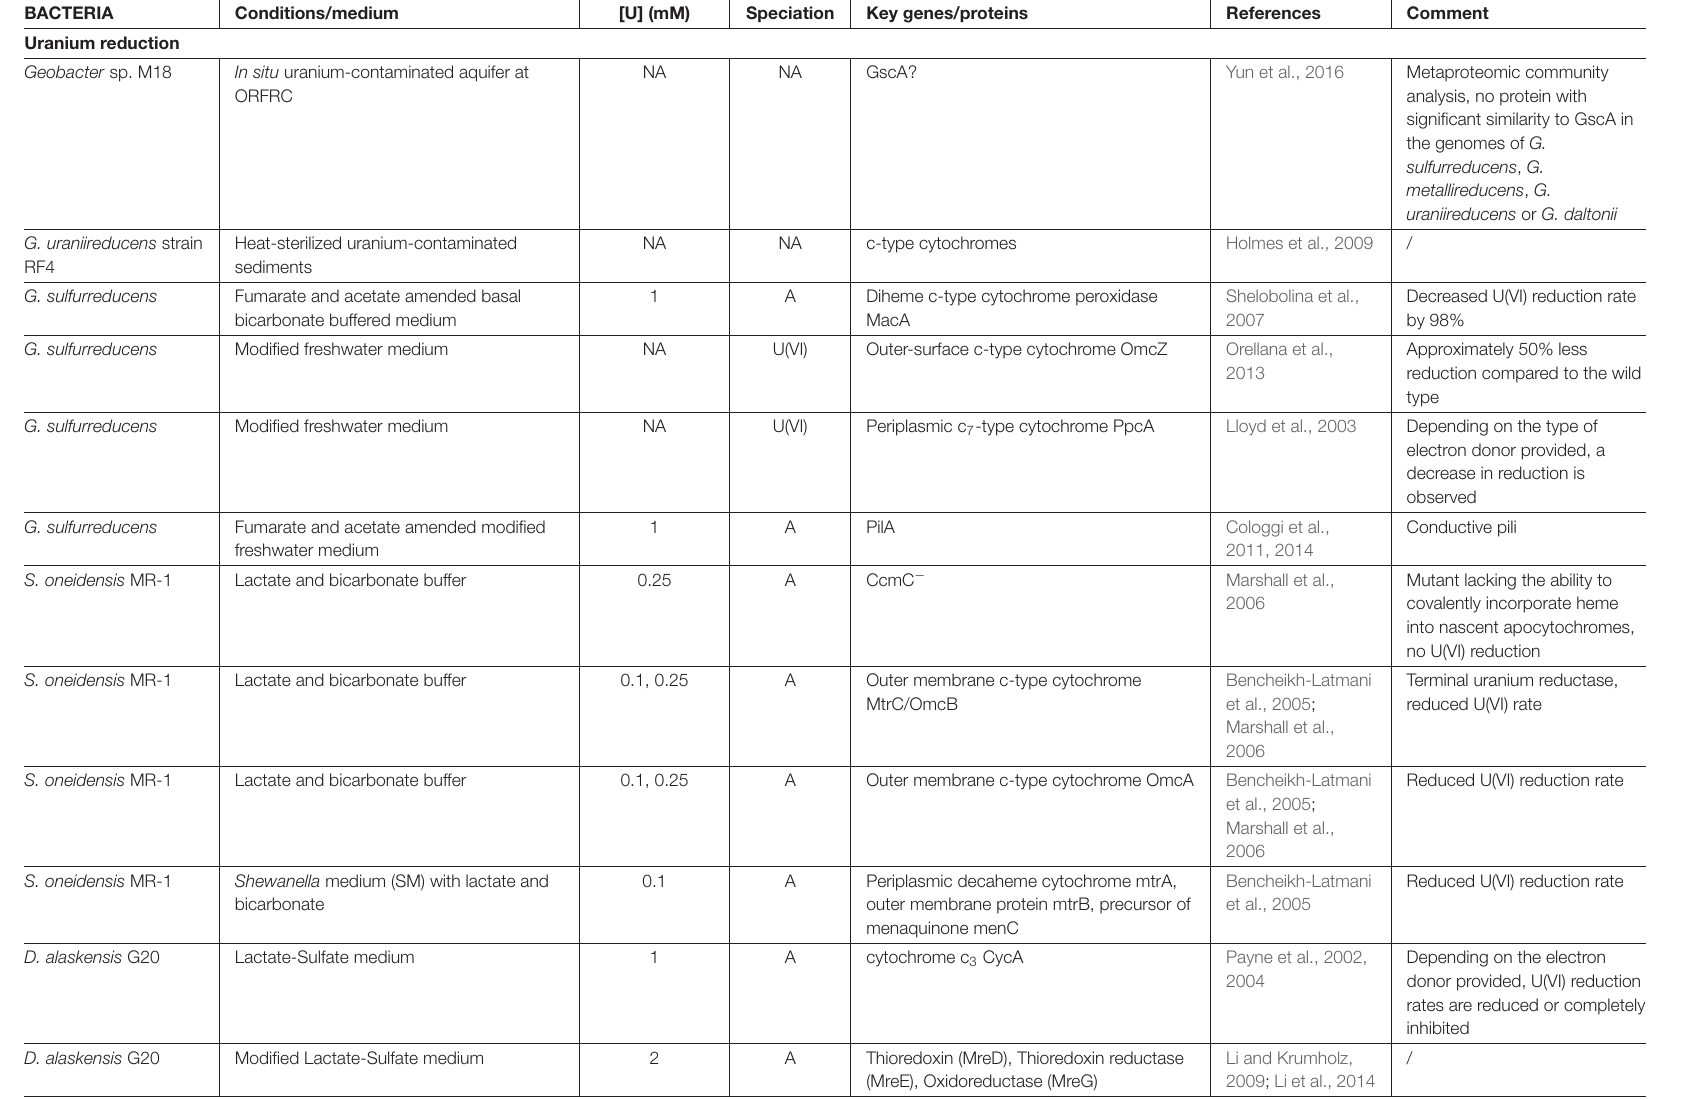
TABLE 1 | Overview of uranium interaction mechanisms in